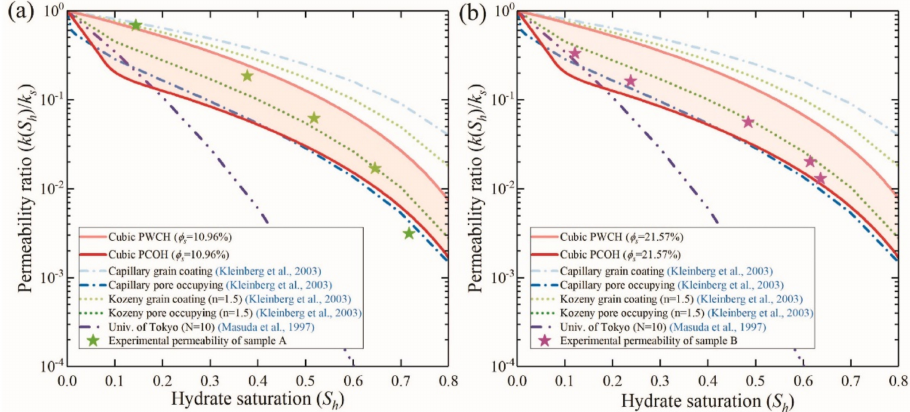
Figure 30. Model validation by the analytical model predictions [23,42] and experimental results from the work by Lei et al. reprinted from [72] with permission from Elsevier. ( a ) Sample A, initial porosity φ 0 = 10.96%; ( b ) sample B, φ 0 = 21.57%. Note: Please refer to the original literature for the experimental data points shown in the figure.